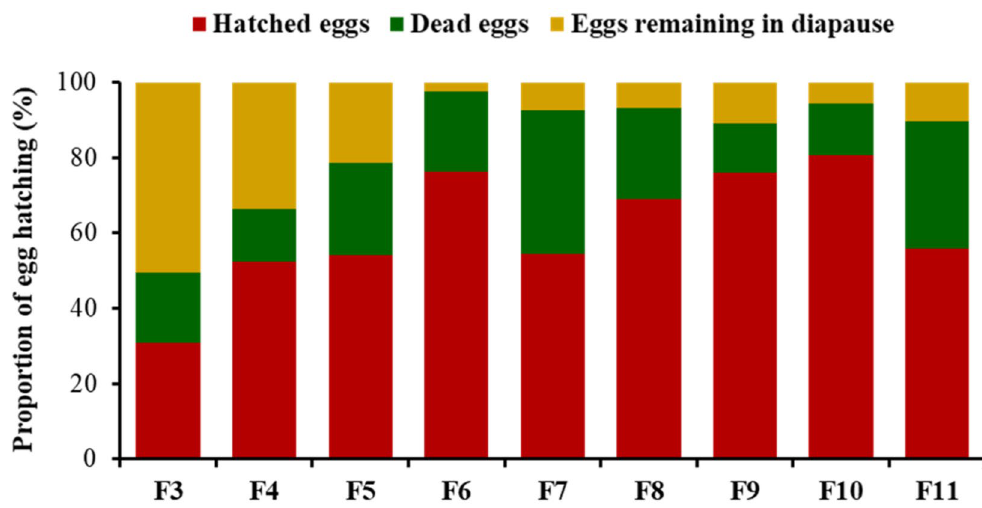
Figure 2. Percentages of hatched eggs, dead eggs, and eggs remaining in diapause for multiple